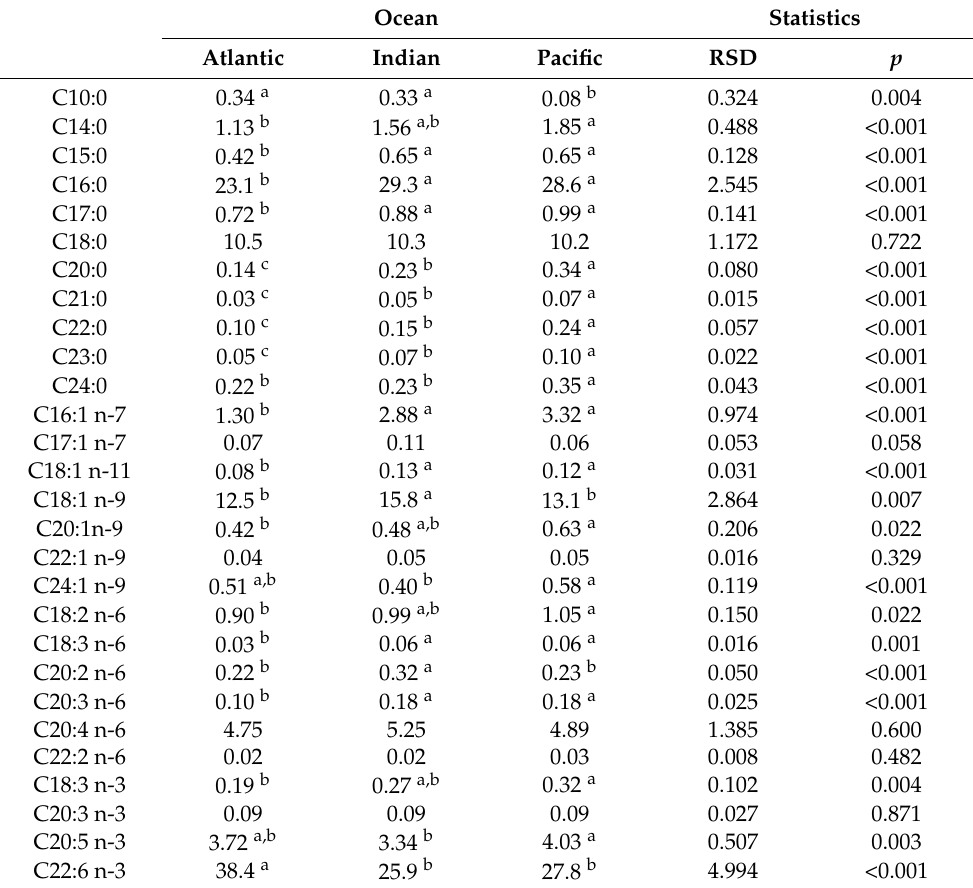
Table 3. Detailed fatty acid profile of yellowfin tuna ( Thunnus albacares ) loin from the Atlantic, Indian and Pacific Oceans (expressed as % of total